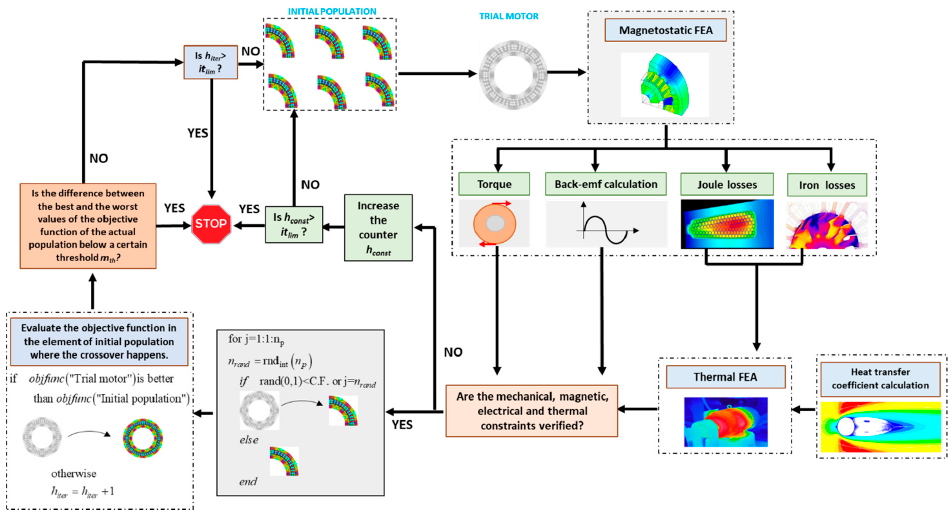
Figure 5. Flowchart of the optimization problem solution by means of DE